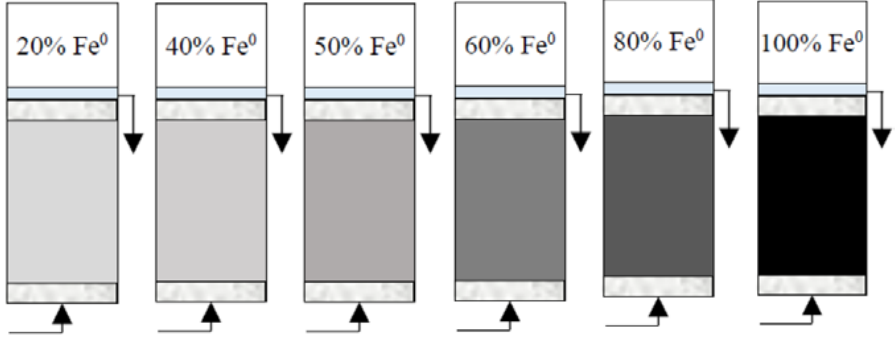
Figure 3. Experimental setup for column tests with reactive zone having variable Fe 0 volume (10, 20, 25, 30, 40 and 50 cm 3 ) and fixed total volume V 2 (50 cm 3 ).